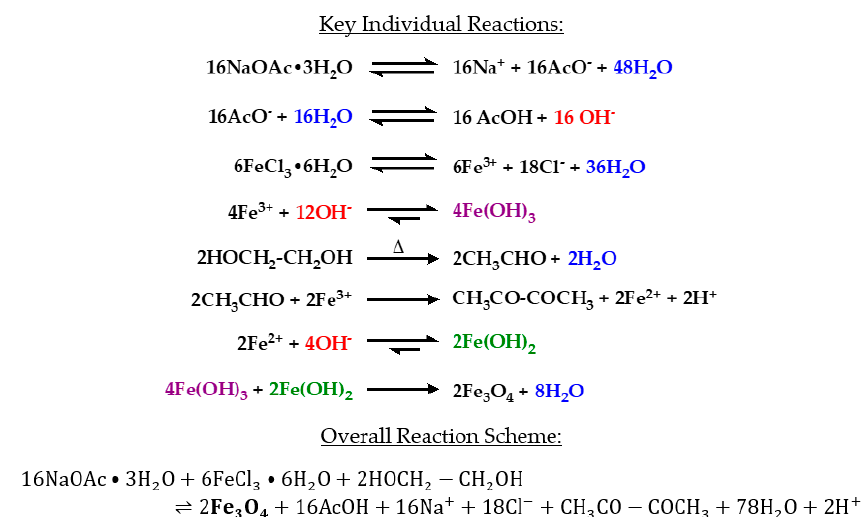
Scheme 1. The reactions involved in the production of iron oxide (magnetite)